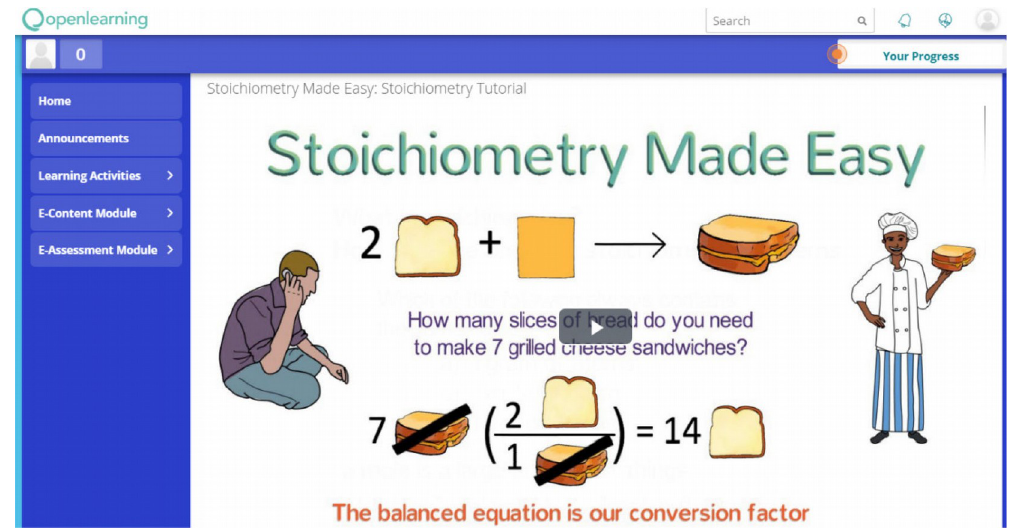
Figure 11. An example of video in the e-content module